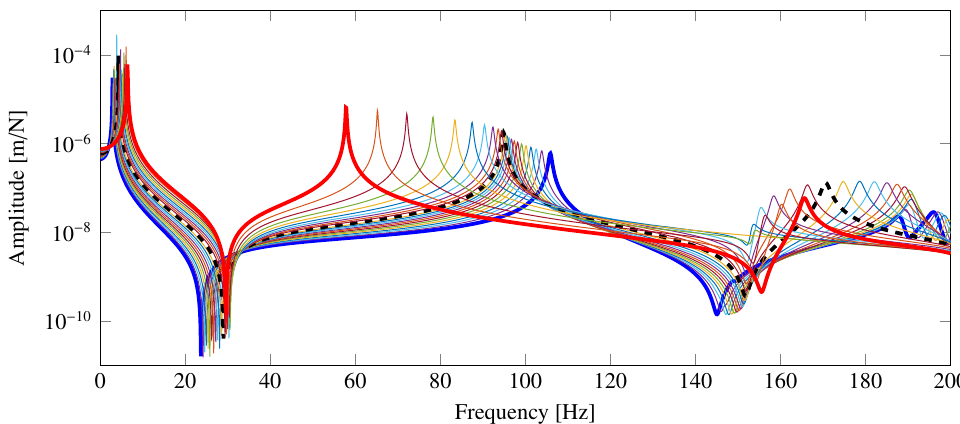
Figure 5. Configuration dependent drive point FRF of node E 1 in the y direction. ( ) α 3 = 90 ◦ ; ( ) α 3 = 180 ◦ ; ( ) α 3 = 140 ◦ .